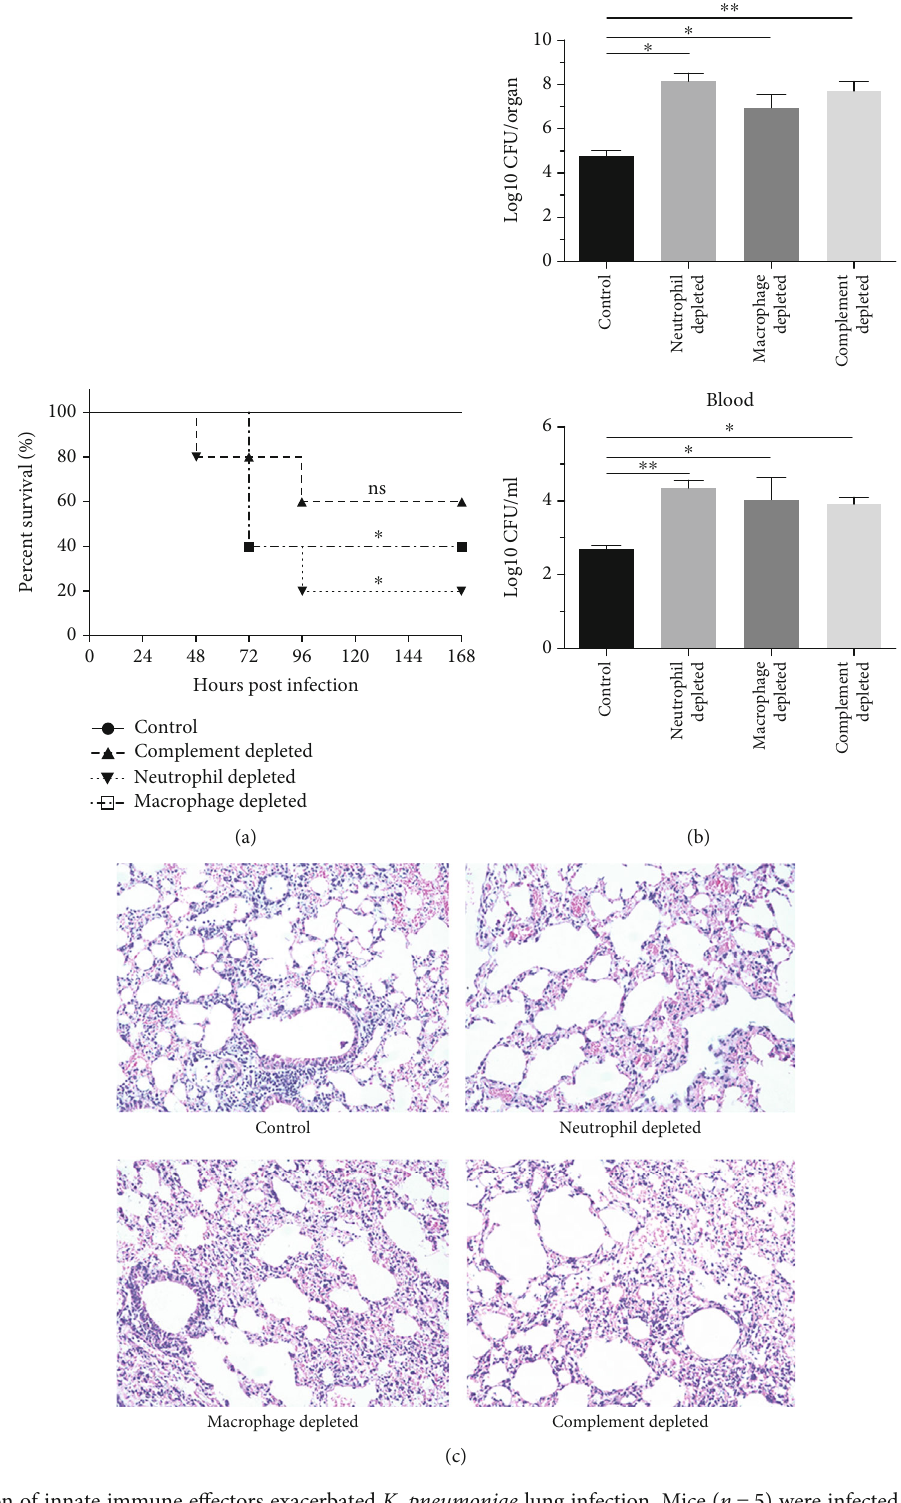
Figure 5: Depletion of innate immune e ff ectors exacerbated K. pneumoniae lung infection. Mice ( n = 5 ) were infected intratracheally with 1 × 10 6 CFUs of strain YBQ and blood and lungs were collected 24h after infection. (a) Survival curves for neutrophil, macrophage, and complement depleted mice were monitored for 7 days. (b) Bacterial burdens in the lungs and blood for di ff erent groups were counted on Luria-Bertani (LB) plates. (c) 24 hours after infection, lung tissues in each group were collected, and lung sections were stained with hematoxylin-eosin, and histopathology of di ff erent groups was evaluated ( magnification = 200 × ). Statistical analyses were performed by Student ’ s t test. P < 0 : 05 ( ∗ ) and P < 0 : 01 ( ∗∗ ) compared to control